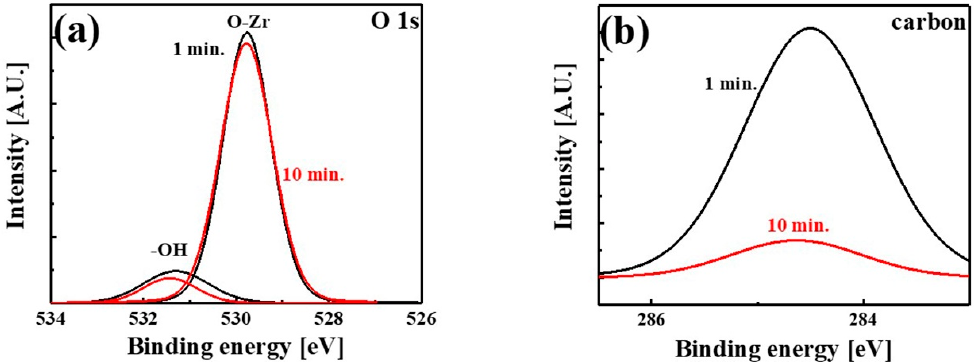
Figure 3. ( a ) O 1s and ( b ) carbon spectra of the ZrO 2 film grown at 300 °C. The measurements were performed after the film was etched for 1 and 10 min to analyze the composition of the film at the surface and in the bulk, respectively.